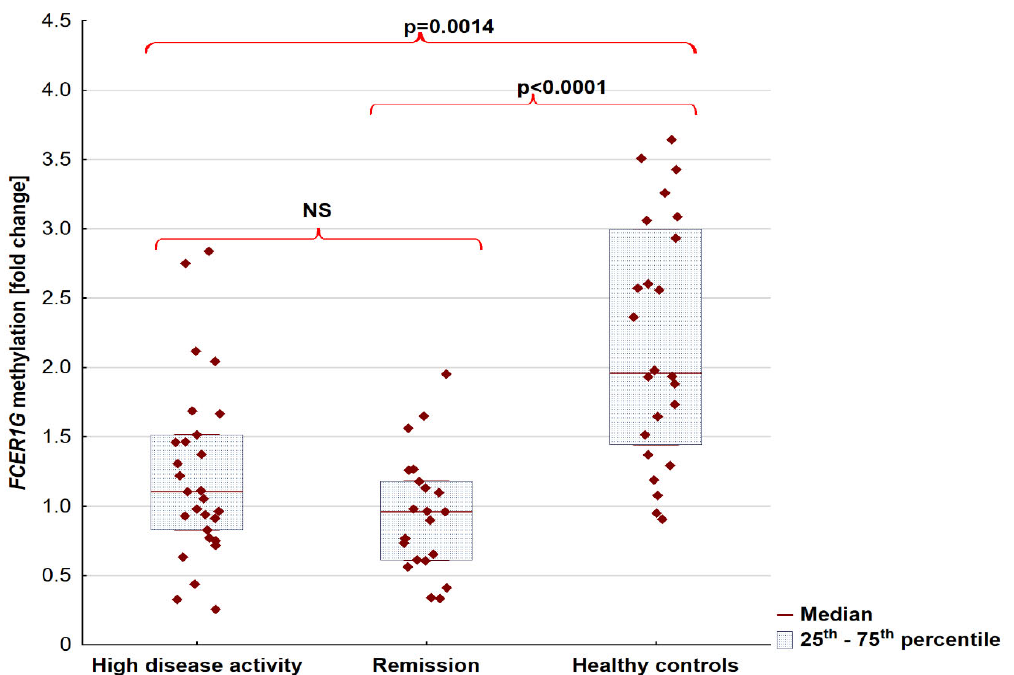
Figure 1. The methylation level of FCER1G in patients with rheumatoid arthritis divided into activity groups and healthy control. Abbreviations: NS, no significant.